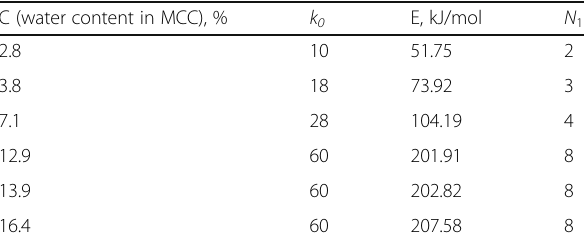
Table 2 Dependencies of activation energy ( E ), pre-exponential factor ( k 0 ), and number of hydrogen bonds N 1 on water content in the investigated samples